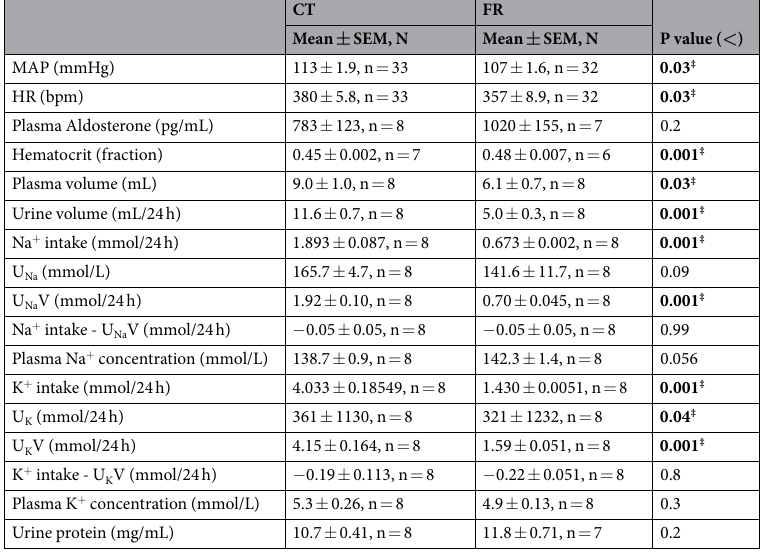
Table 1. Effect of FR on hemodynamic and urine and plasma parameters. Basal physiological values in female rats subjected to control (CT) or food restricted (FR) diet for 14 days. ‡ P < 0.05 vs CT, by unpaired Student’s t- test. BW, body weight; MAP, mean arterial pressure; HR, heart rate; U Na V, urinary excretion of Na + ; U K V, urinary excretion of K +